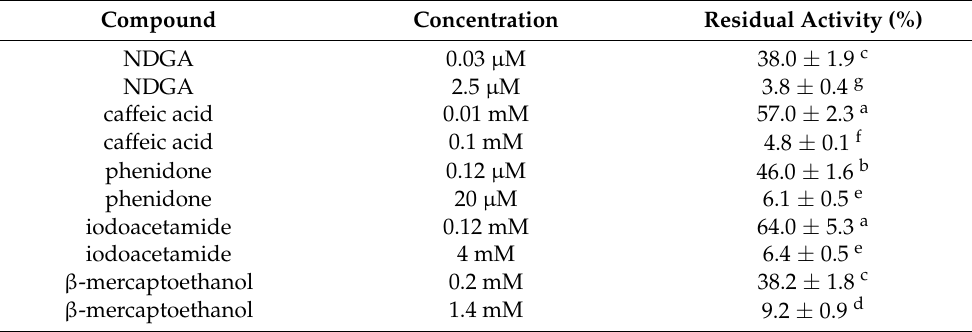
Table 1. Effects of inhibitors on the activity of porcine 12-LOXcd (mean ± SD, n = 3) 1 . Compound Concentration